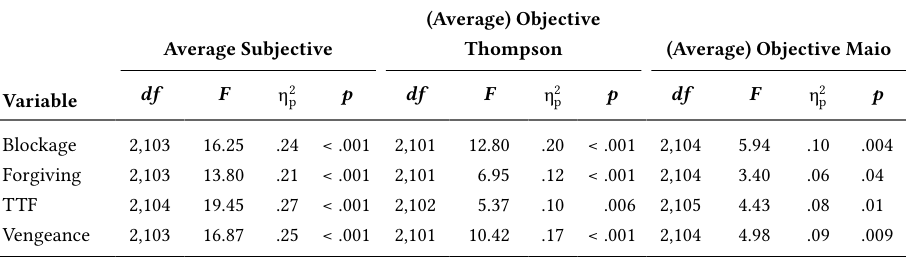
One-way ANOVAs Comparing High Ambivalence, Anti-, and Pro-Forgiveness Groups